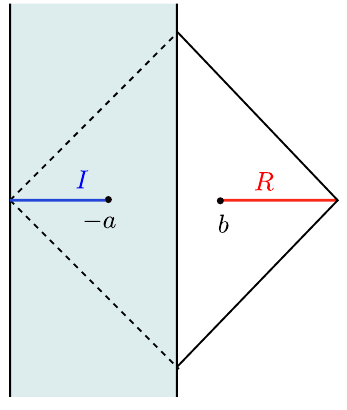
Figure 13 . An information puzzle at zero temperature, with AdS 2 on the left and (cid:13)at space on the right. The naive calculation of matter entropy in region R is infrared-divergent, but this cannot be puri(cid:12)ed by quantum gravity in AdS 2 . This is resolved by including the island, I